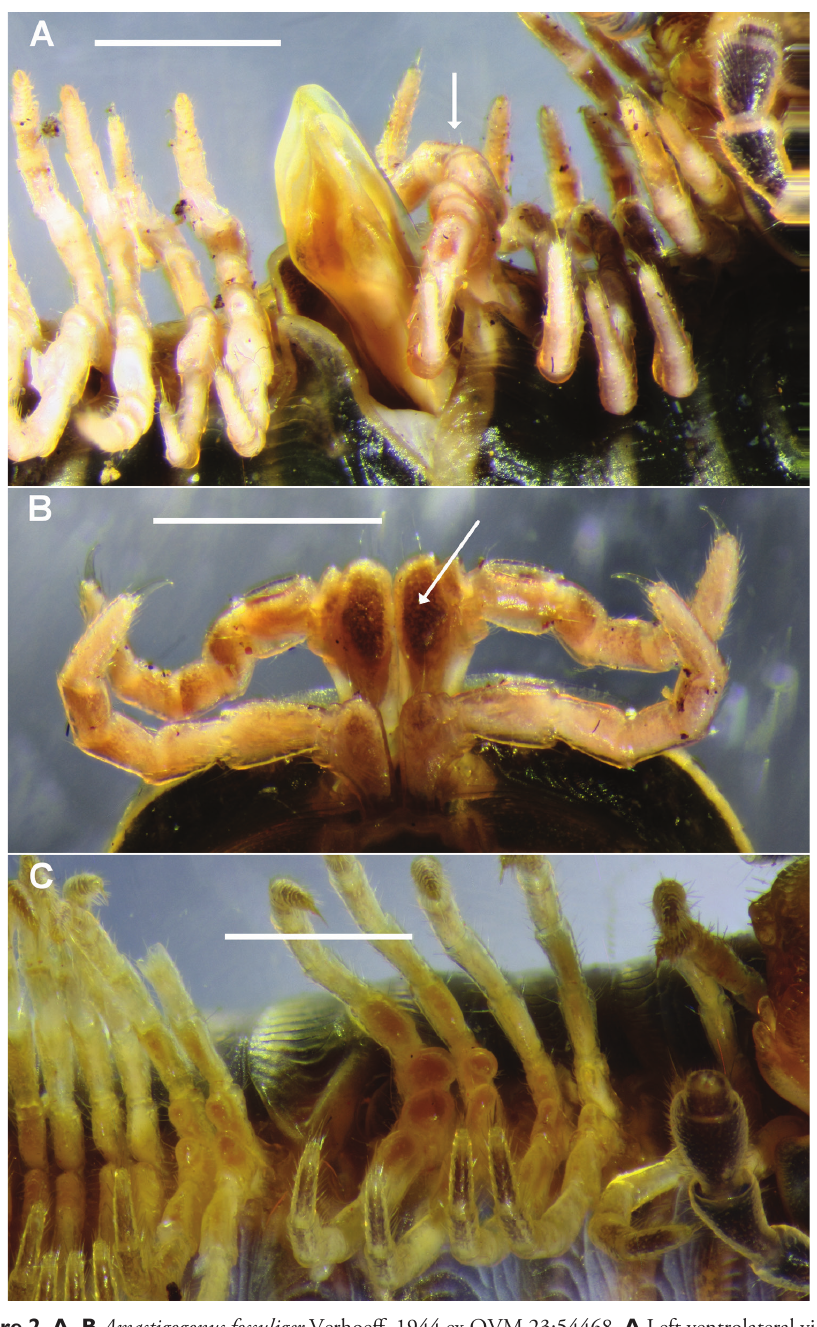
Figure 2. A, B Amastigogonus fossuliger Verhoeff, 1944 ex QVM 23:54468. A Left ventrolateral view of male with partly everted gonopods, showing legpair 7 (arrow) with elongated coxae B Anterior view of legpairs 6 and 7 on isolated ring 6 of same male, with leg 7 coxa marked with arrow C A. danpicola sp. n., QVM 23:54403, left ventrolateral view of male. Scale bars = 1